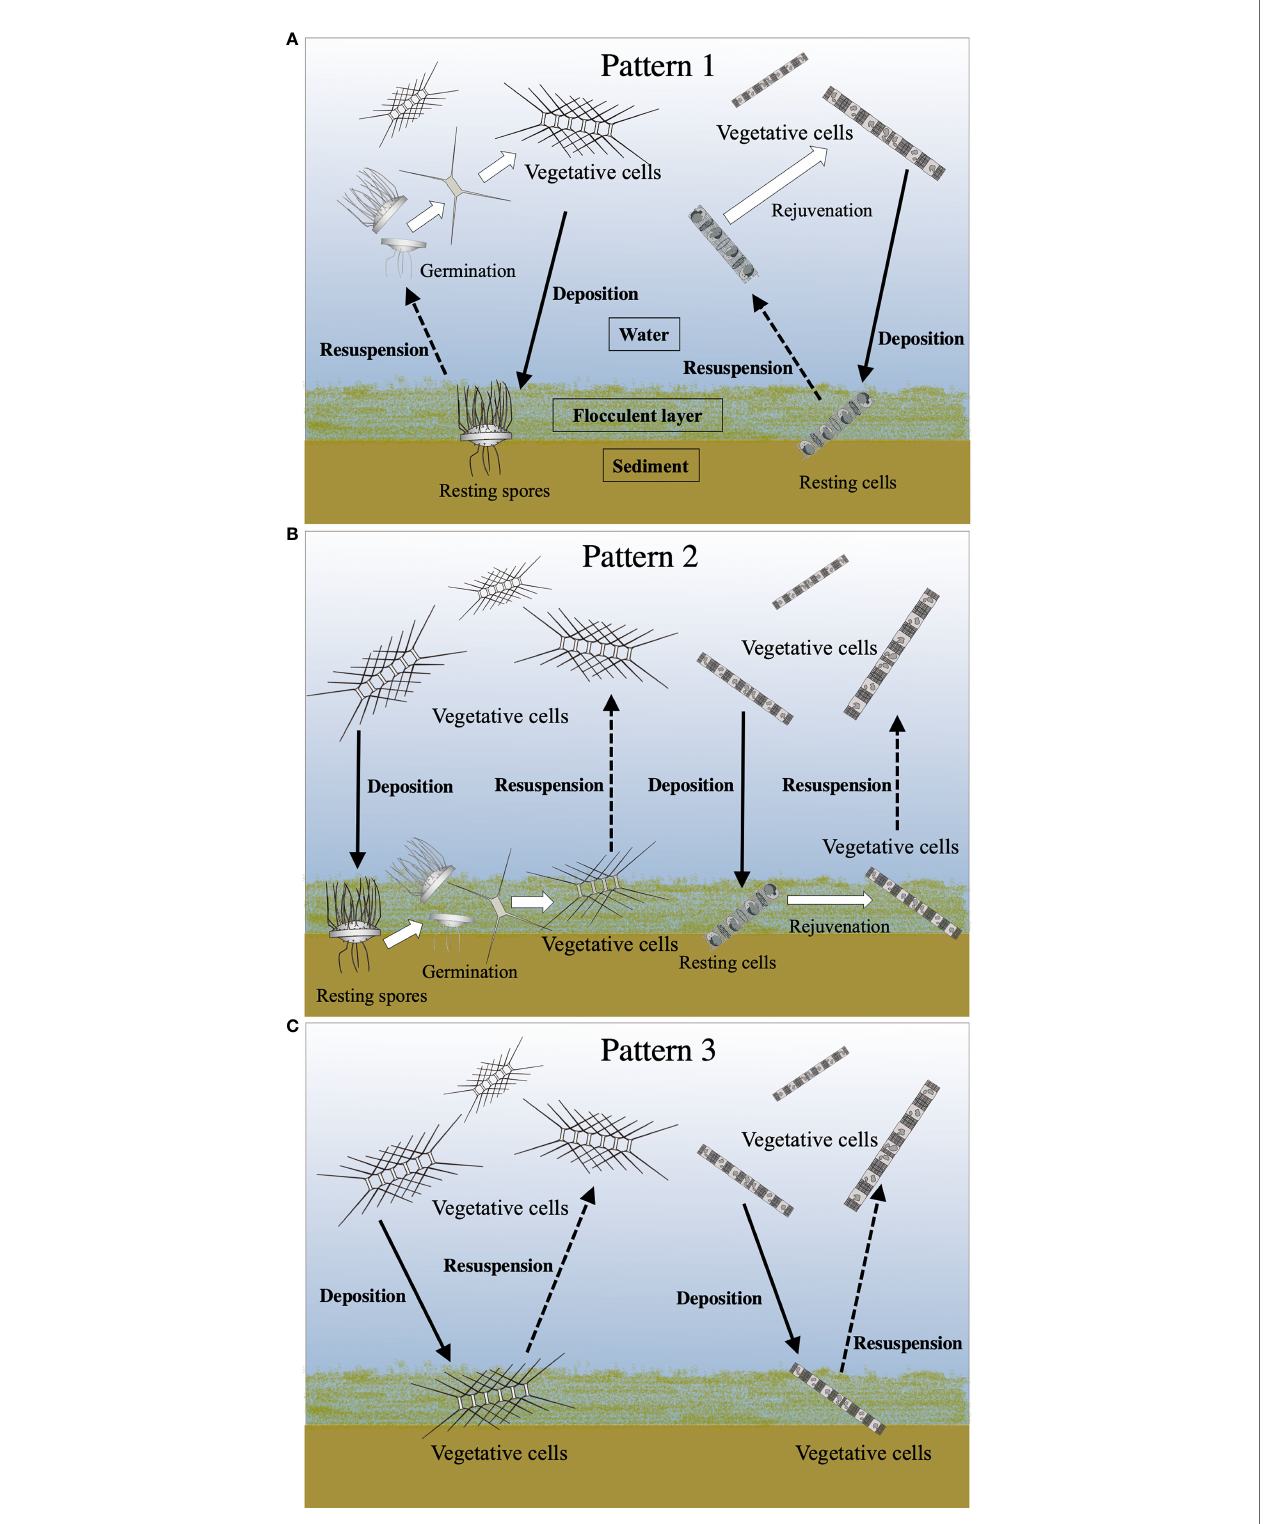
FIGURE 10 | Conceptual diagrams of various life cycle patterns of the centric diatoms. See the text for details of Pattern 1 (A) , Pattern 2 (B) and Pattern 3 (C) . Solid and dotted lines indicate the movement (deposition and resuspension, respectively) of the cells between the water column and the surface sediment. White arrows denote transformations of the cell